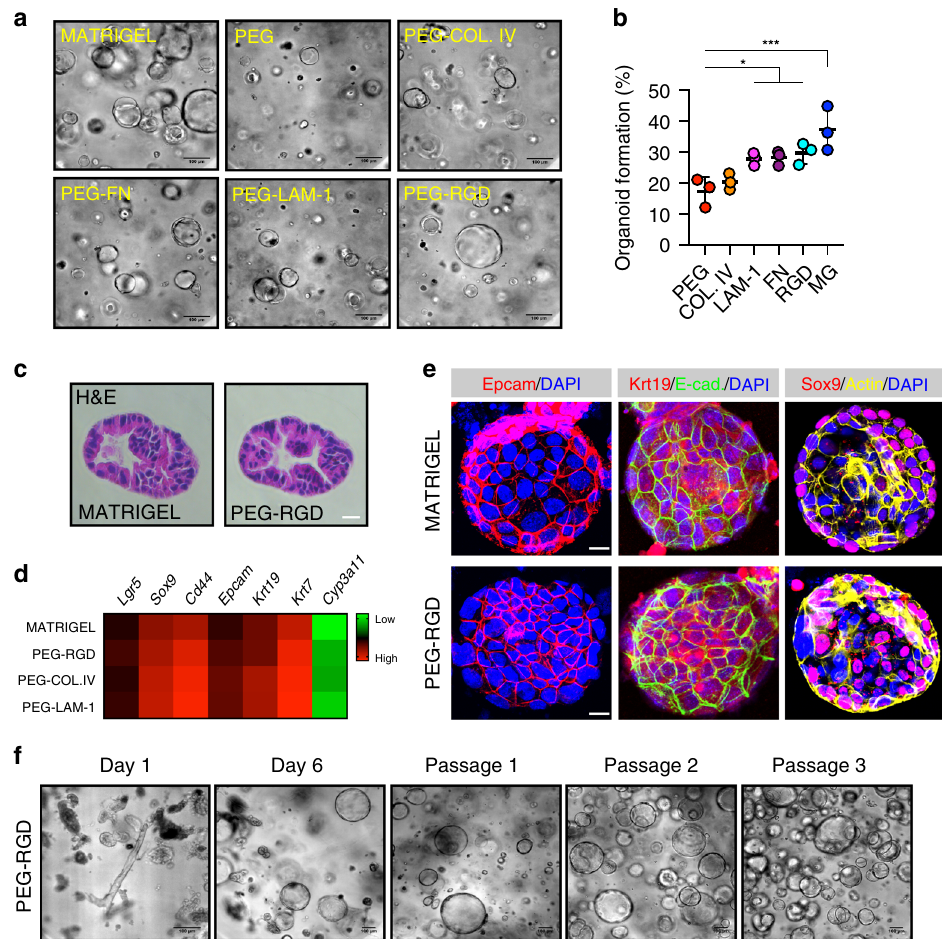
Fig. 1 Liver organoid growth in Matrigel and PEG supplemented with ECM components. a Mouse liver progenitor cells 3 days after embedding in: Matrigel (MG), plain PEG (PEG) and PEG functionalized with the indicated ECM components: COL.IV (collagen IV), FN ( fi bronectin), LAM-1 (laminin-1) and RGD-representing peptide (RGD). b Quanti fi cation of organoid formation ef fi ciency relative to panel a . Graphs show individual data points derived from n = 3 independent experiments and means ± s.d., one-way Anova. * P < 0.05, *** P < 0.001. P = 0.0321; P = 0.0266; P = 0.0119; P = 0.0003. Source data are provided as a Source Data fi le. c Hematoxylin and eosin staining of Matrigel- and PEG-derived organoids. Scale bar 25 μ m. d Gene expression was analysed by qRT-PCR in liver organoids 6 days after embedding in Matrigel and PEG hydrogels supplemented with different ECM factors. The heatmap represents Δ Ct values as described in the method section. e Liver organoid immunostaining was performed 6 days after embedding of liver progenitor cells in Matrigel or PEG-RGD. f Liver organoids can be cultured in PEG hydrogels by directly embedding mouse biliary duct fragments. Representative pictures are shown. Micrographs ( c , e , f ) are representative of three independent